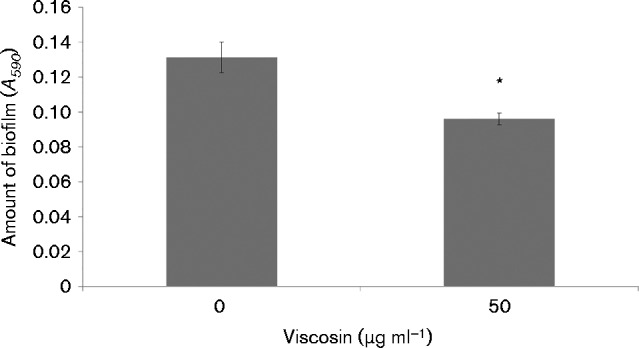
Mature biofilms of P. fluorescens SBW25ΔviscA complemented with purified viscosin at concentrations of 0 and 50 μg ml− 1. Biofilms were quantified after 9.5 h of incubation with and without viscosin by the crystal violet assay. Data represent mean ± sd for a representative dataset including eight replicates. *Significant difference (P < 0.05) compared with the control (0 μg ml− 1).